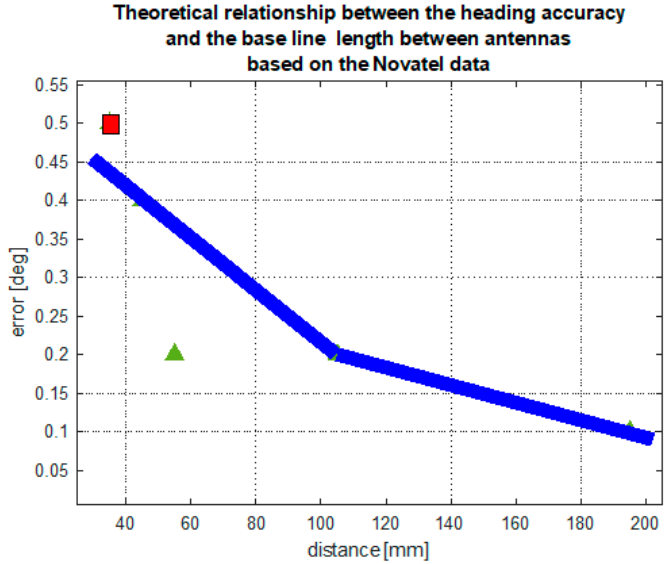
Figure 1. The idea of the use of two antennas to determine the heading of the ship [1]. Figure 23. Theoretical relationship between the heading accuracy and the base line length between antennas, based on the Novatel data published in the device documentation ( black curve ). Declared accuracy of the Furuno compass as a function of baseline ( red square ) and of the Advanced Navigation compass ( green triangle